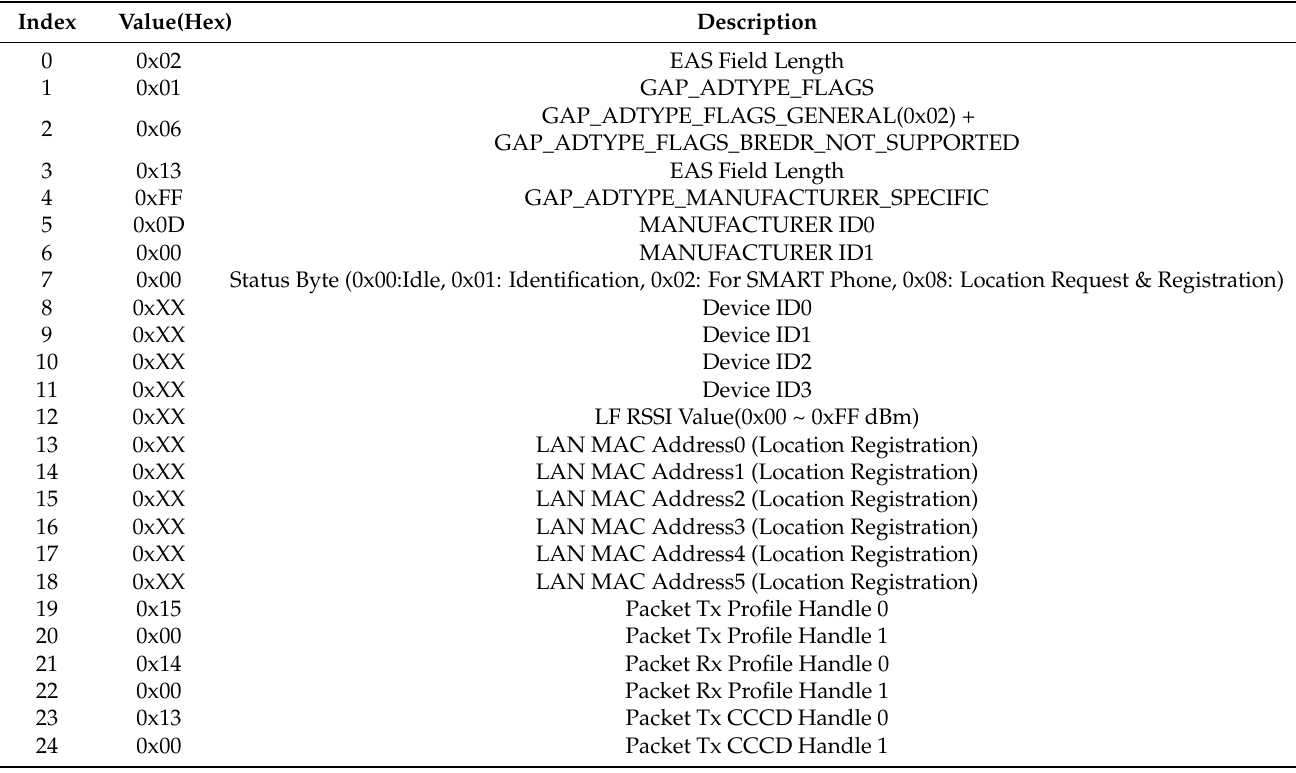
Table 3. Bluetooth Low Energy (BLE) Advertising Data for ADL Diagnosing